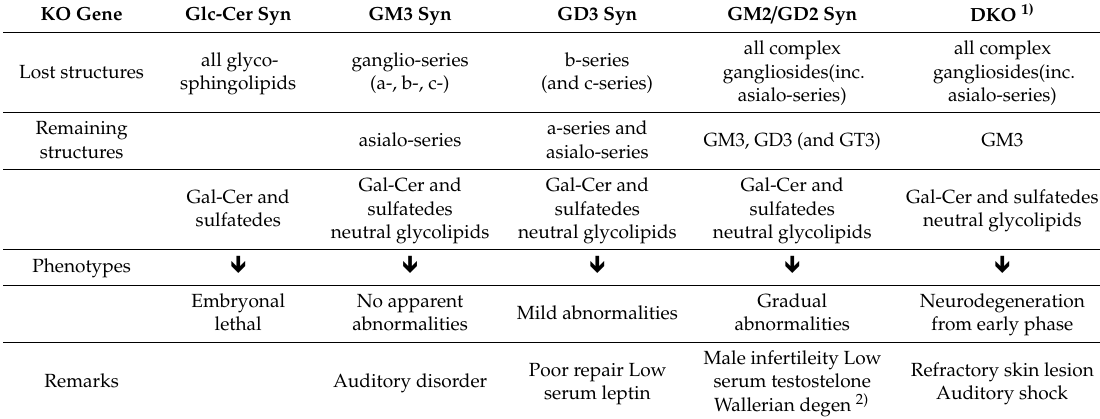
Table 1. Deficient structures, remaining glycolipids, and phenotypes of individual KO mice of glycosyltransferase genes. Residual glycolipids could compensate for the functions that deleted structures primarily exerted.